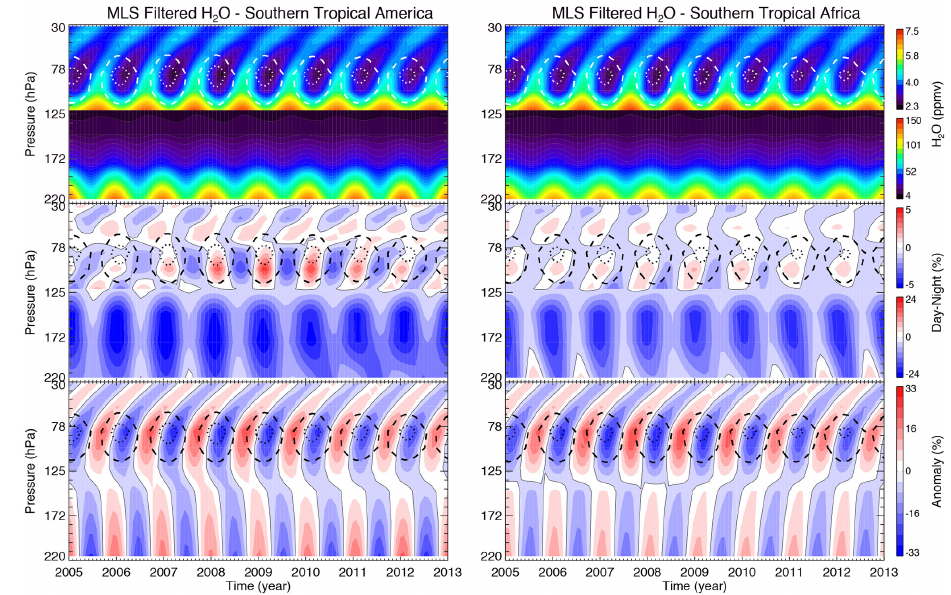
Figure 6a. (Left, from top to bottom) MLS 2005–2012 monthly-averaged filtered H 2 O, relative filtered D-N and relative filtered anomaly time series from 220 to 30hPa in southern tropical America. The white (top) and black (middle and bottom) dashed (dotted) lines show the filtered temperature 195K (190K) contour. Note the use of a different colour scale from 121 to 30hPa compared to 220–121hPa for the top and middle figures. (Right) Same as left but for southern tropical